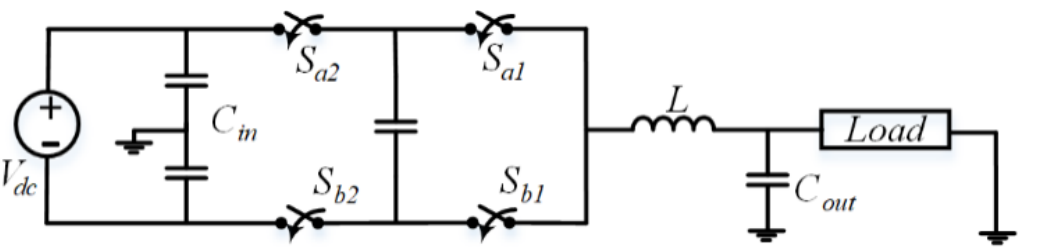
Figure 3. Three-level switched-capacitor inverter topology [11].